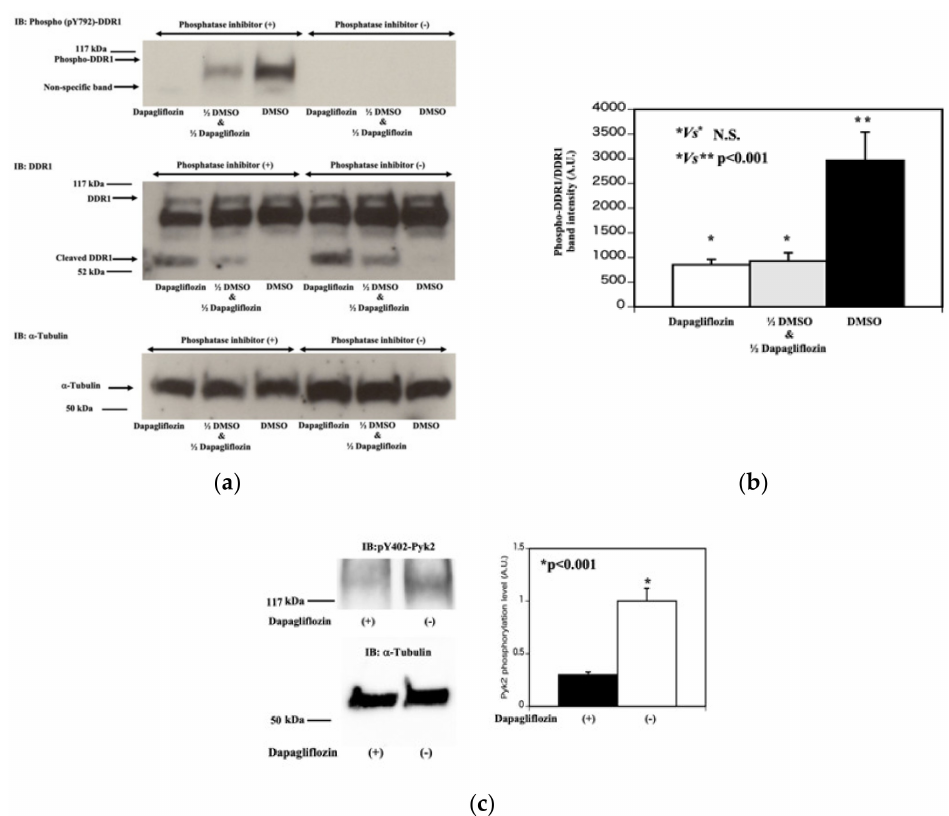
Figure 6. Dapagliflozin increases tyrosine phosphatase activity that reduces DDR1 dephosphorylation. ( a ) DDR1 tyrosine phosphorylation. HCT116 cells were treated with vehicle (DMSO) or 0.5 mM dapagliflozin for 20 min. The cells were extracted in bu ff er with ( + , 1–3 lanes from the most left lane) and without ( − , 4–6 lanes from the most left lane) the phosphatase inhibitors (Sodium vanadate, Sodium pyrophosphate, Sodium Fluoride). Fifty microliters of lysate from DMSO treated HCT116 cells